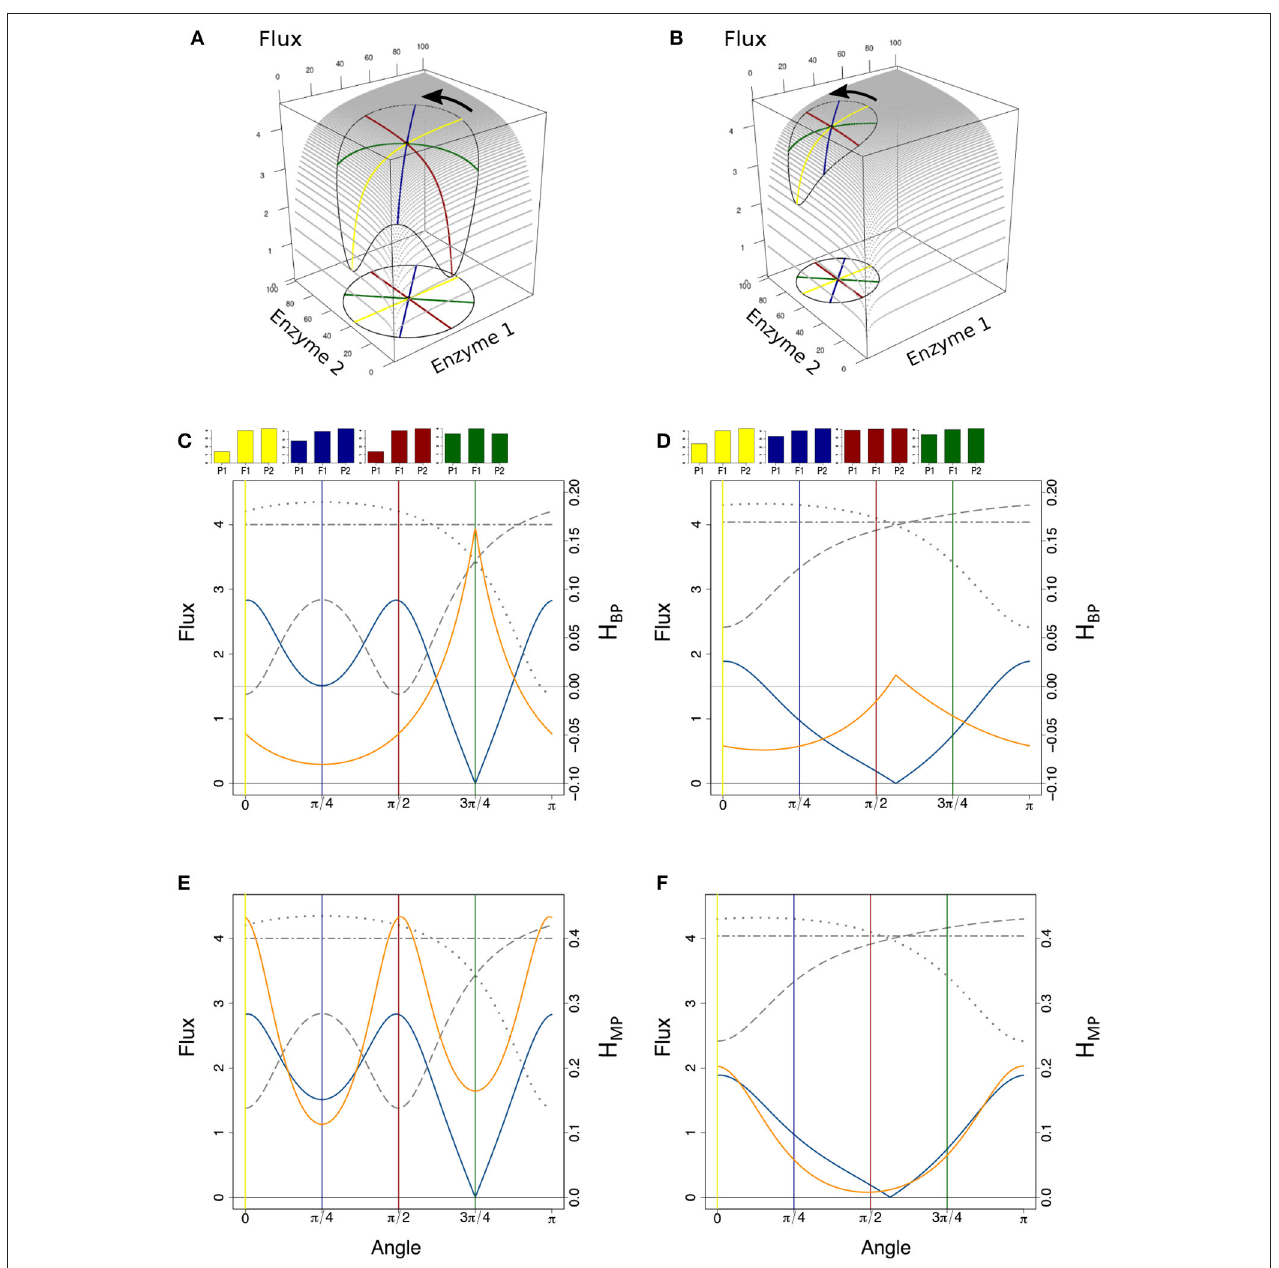
FIGURE 14 | The geometry of heterosis when the enzymatic distance between parents is constant. (A) Parental enzyme concentrations are on a circle of diameter D enz y 76 centered on the hybrid point, the coordinates of which are x 40. Four pairs of parents are highlighted by yellow, blue, red and green diameters. The = = = 1 closed curve on the surface shows the flux values corresponding to the circle of concentrations. The equation of the flux surface is J 1 / ( 1 E E 2 + 0.2), in arbitrary = 1 + units. (B) Same as (A) , except that D enz 50 and hybrid coordinates are x 30 and y 70. (C) Variation of parental fluxes J 1 and J 2 (dotted and long-dashed gray = = = π curves), of D flux (blue curve) and of H BP (orange curve) over the rotation of a segment joining the parents from α 0 (parallel to the x-axis, yellow case) to α = = (reversed positions of the parents). The two-dashed horizontal gray line corresponds to the constant hybrid flux value. The yellow, blue, red, and green vertical lines correspond to the pairs of parents of the 3D vignette in (A) , with barplots showing corresponding heterosis. (D) Same representation as in (C) , for the case shown in (B) . (E,F) : Same as in (C,D) , with H MP instead of H BP .